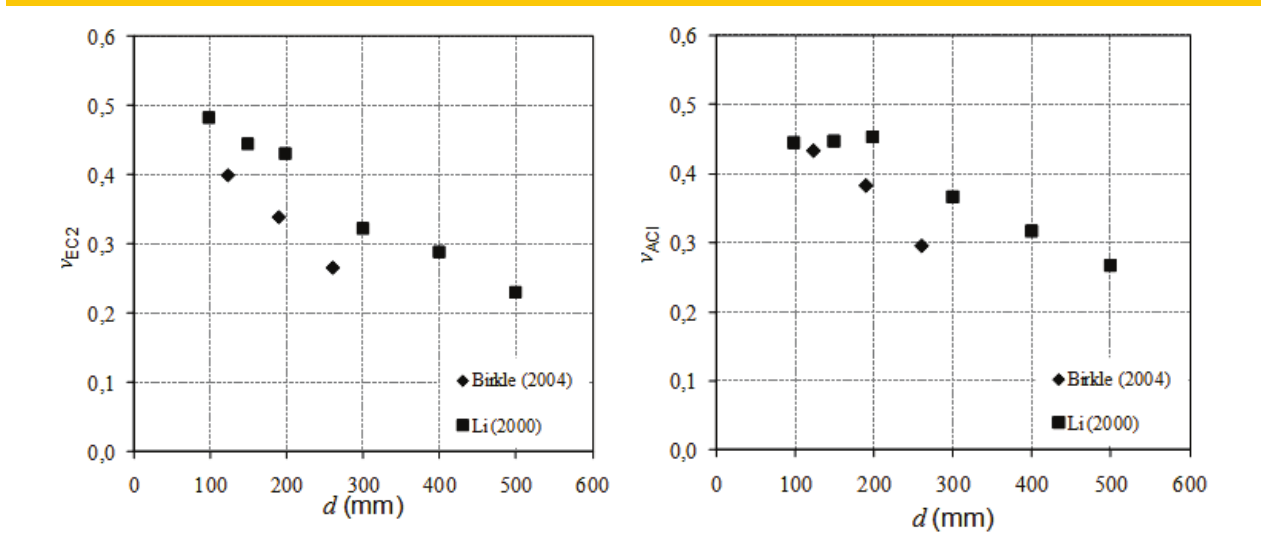
Figure � � �ariation of the nominal shear strength as a function of the effective depth of the